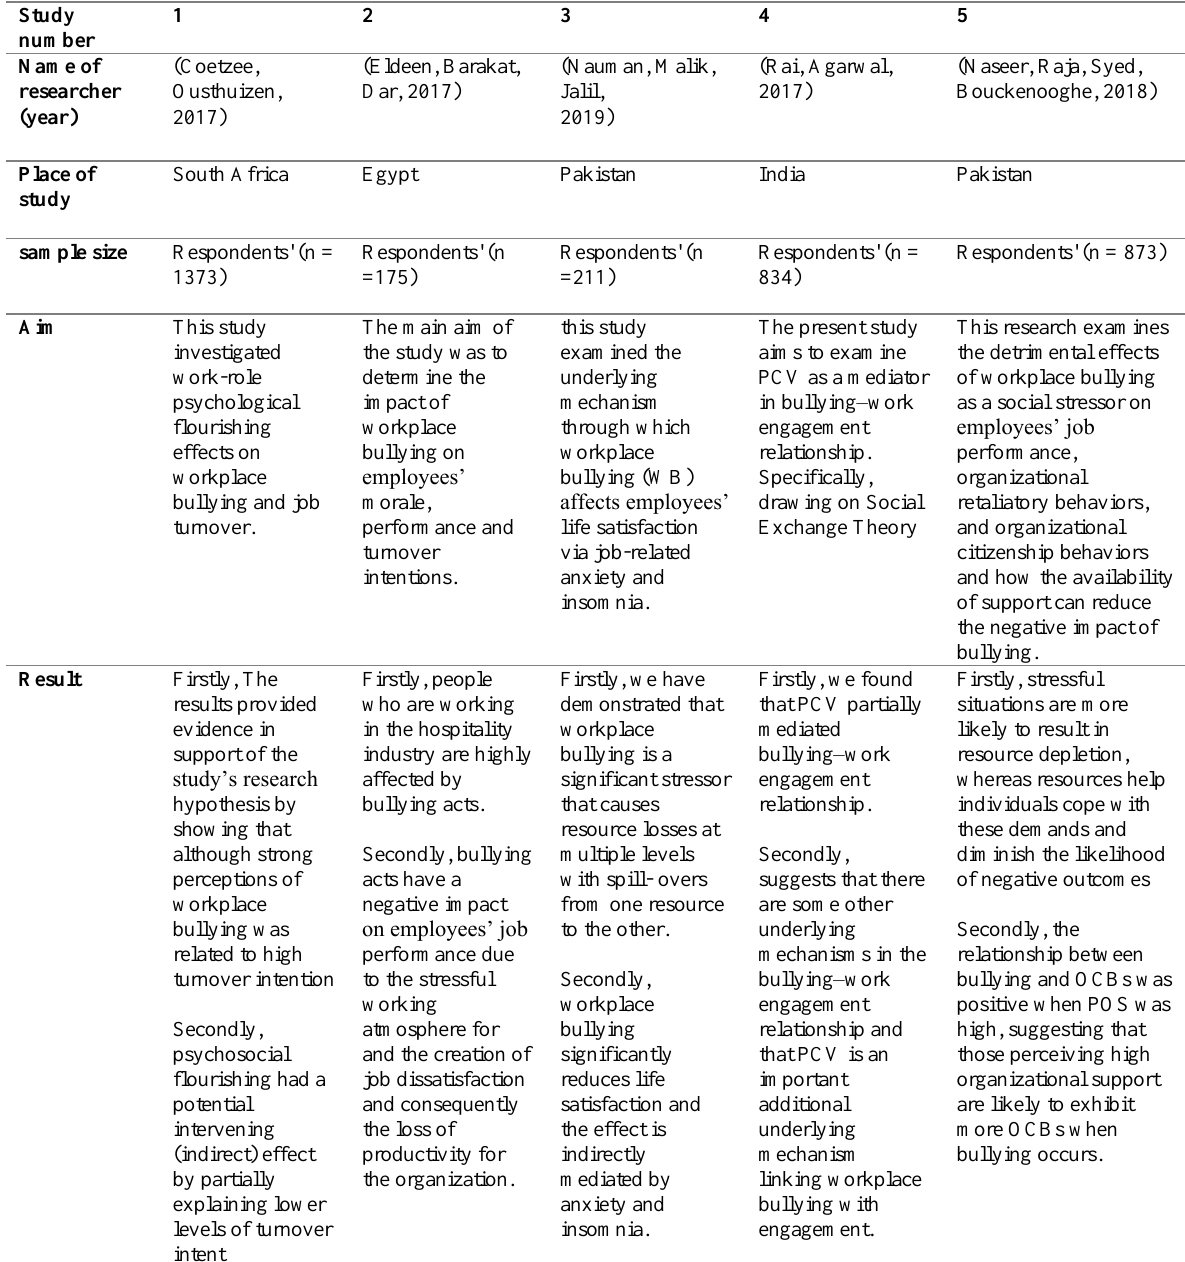
Table 2: Empirical studies for reducing workplace